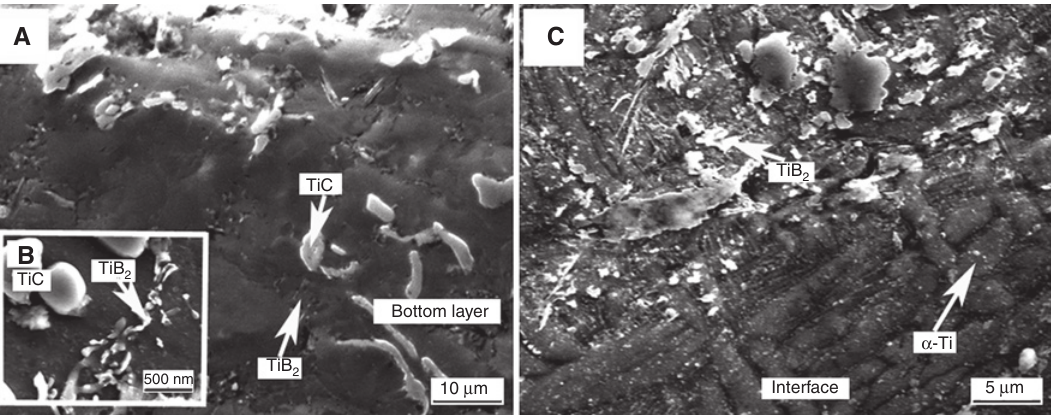
Al-B C-YPSZ-Al O laser clad composites, (A) bottom layer, (B) TiC and the TiB 3 4 2 3